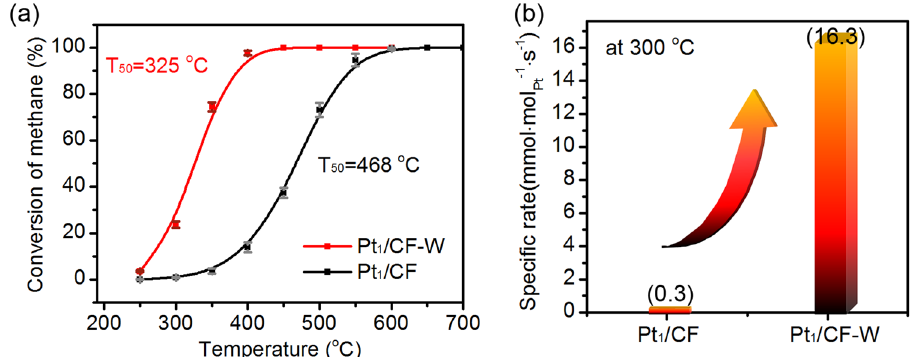
Fig. 3 Catalytic activity of methane combustion. a Light-off curves of CH 4 lean-burn combustion over Pt 1 /CF and Pt 1 /CF-W. Reaction conditions: 0.5 vol% CH 4 , 20 vol% O 2 , N 2 ; Gas hourly space velocity (GHSV) = 20,000 ml/(g cat ·h). The error bars represent the standard deviation based on four repeated light-off experiments. b Speci fi c rate of CH 4 conversion on Pt 1 /CF and Pt 1 /CF-W at 300